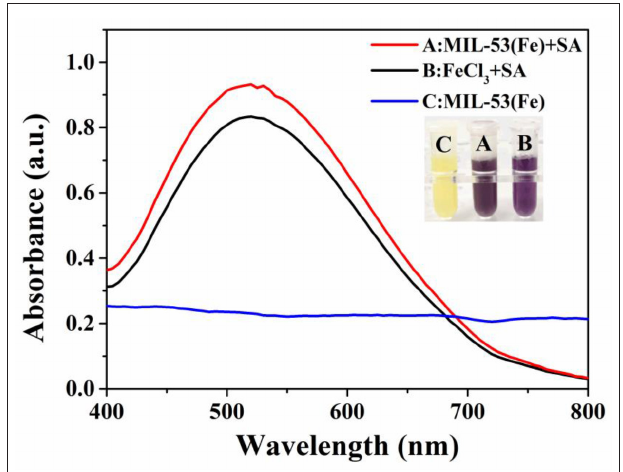
FIGURE 3 | The absorption peaks of SA-Fe(III) complex characterized by UV-Vis spectra: (A) MIL-53(Fe) + SA, (B) FeCl 3 + SA, (C) MIL-53(Fe). Inset: the corresponding photograph of different systems.